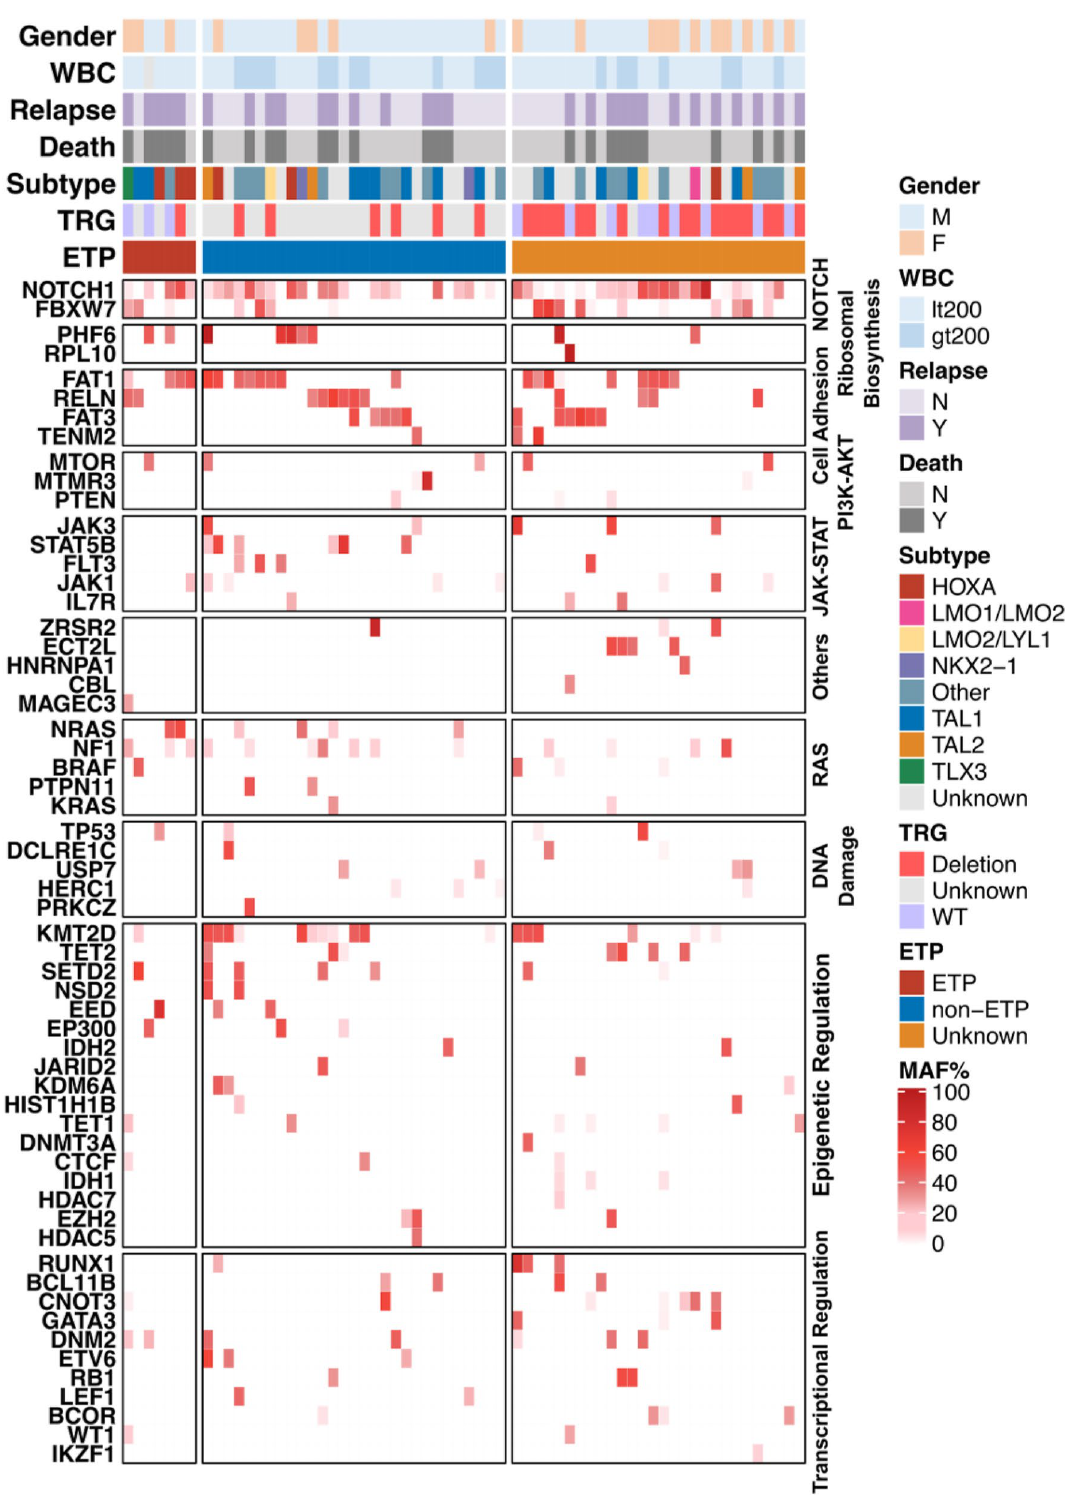
Figure 2. Genetic alteration profiling in 64 cases of T-cell acute lymphoblastic leukemia. Each column represents the genetic alterations of a single patient. AF alternative allele fraction, TRG T cell receptor-γ